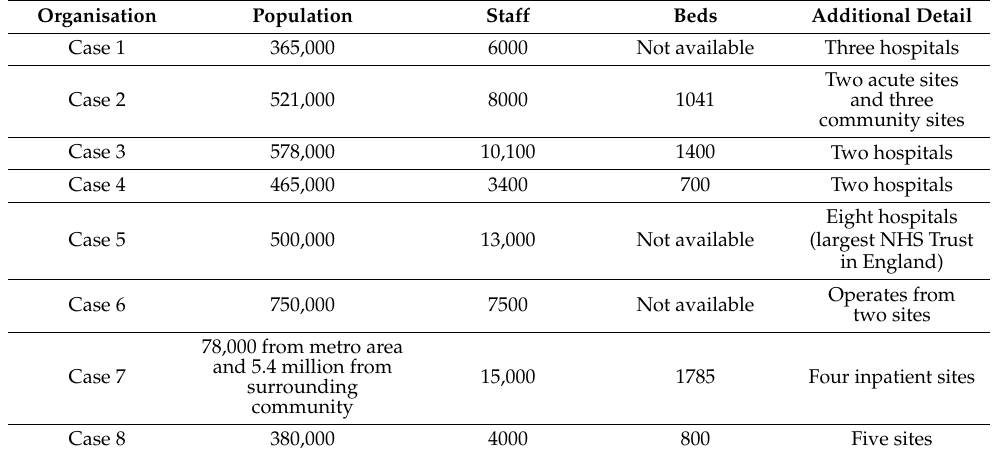
Table 2. Organisation characteristics (source: [20] and data in italics is from organisations’ website). Organisation Population Staff Beds Additional Detail Case 1 365,000 Not available Two acute sites 521,000 1041 and three community sites 578,000 Eight hospitals Not available (largest NHS Trust in England) 7500 Not available Operates from two sites 78,000 from metro area and 5.4 million from 15,000 1785 Four inpatient sites surrounding community Case 8 380,000 4000 800 Five